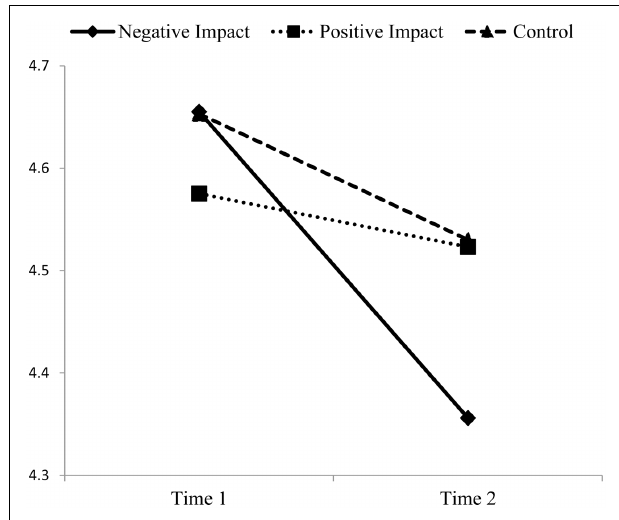
FIGURE 1 | Job performance pre- and post-intervention.